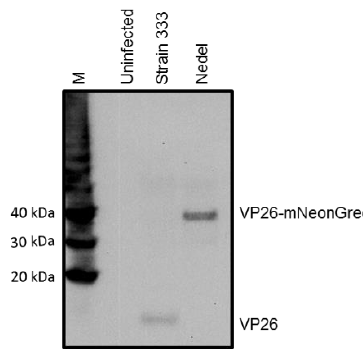
Figure 1. Western blot, visualized with anti-VP26 antibody, indicating that Nedel expresses VP26-mNeonGreen fusion protein. Vero cells were harvested 24 h after infection at an MOI of 10 with either Strain 333 or Nedel. Magic Marker protein standards (M), uninfected Vero cells, HSV-2 Strain 333-infected Vero cells, and Nedel-infected Vero cells are in the lanes left to right.